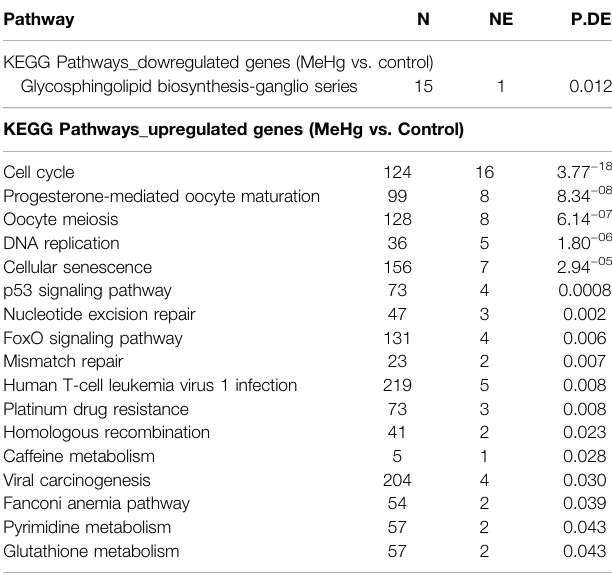
TABLE 2 | Enrichment of pathways and ontologies in upregulated or downregulated in the exposed group of human salivary gland cells line to